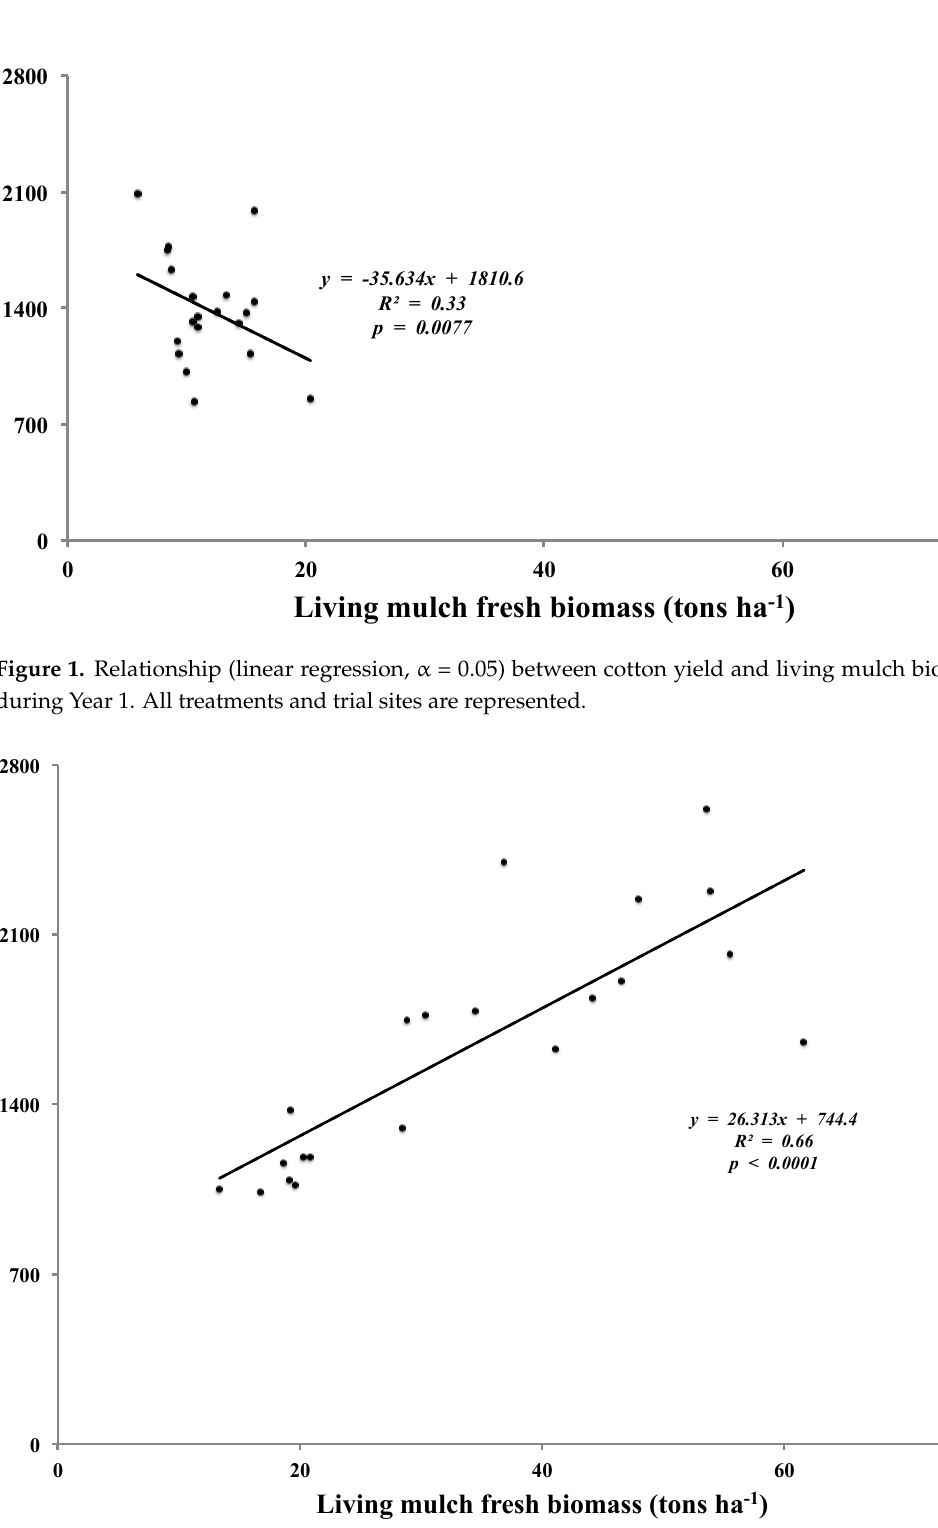
Figure 2. Relationship (linear regression, α = 0.05) between cotton yield and living mulch biomass during Year 2. Only data from sesbania and sunnhemp treatments are represented. Site 3 has been excluded.